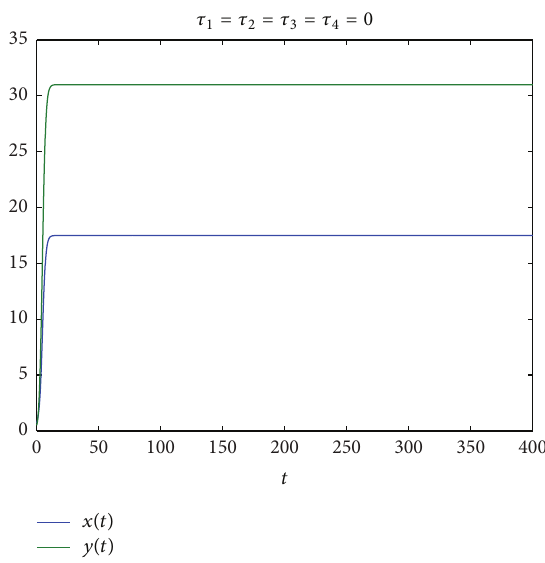
Figure 1: The positive equilibrium of system (115) is locally asymp- totically stable for 𝜏 1 = 𝜏 2 = 𝜏 3 = 𝜏 4 = 0 with initial value “0.7,